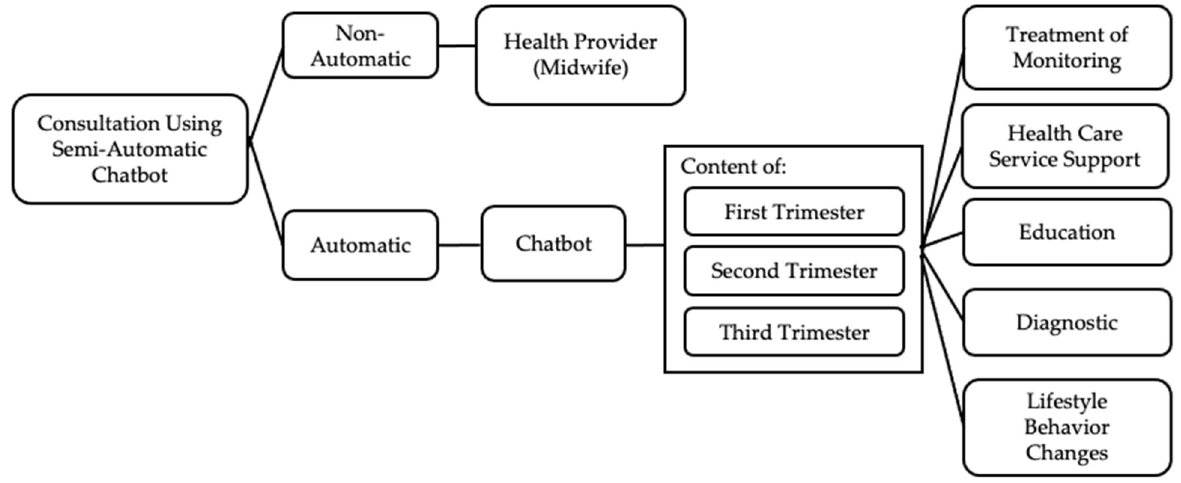
Figure 2. Consultation structure via semi-automated chatbot.